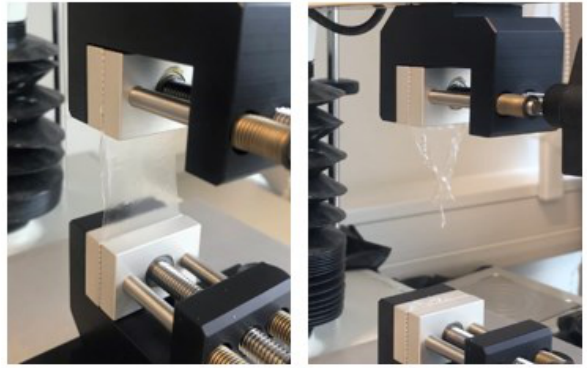
Figure 11. Film before (left) and after (right) tensile test. Figure 10. Comparison of tensile strength by composition (n = 6). The composition values are given